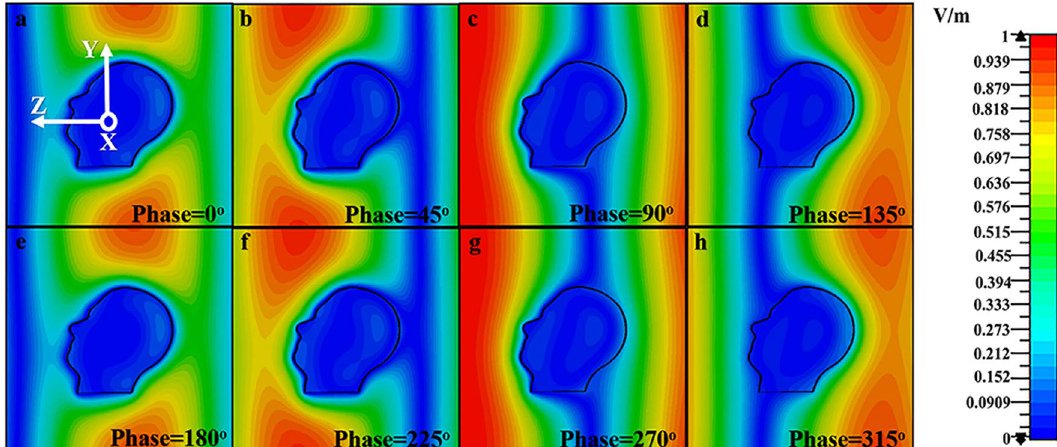
Figure 2. The field distribution under 250 MHz pulse radiation along the Z direction in the simulation region with different phases. (a) Phase = 0 ◦ , (b) Phase = 45 ◦ , (c) Phase = 90 ◦ , (d) Phase = 135 ◦ , (e) Phase = 180 ◦ , (f) Phase = 225 ◦ , (g) Phase = 270 ◦ , (h) Phase = 315 ◦